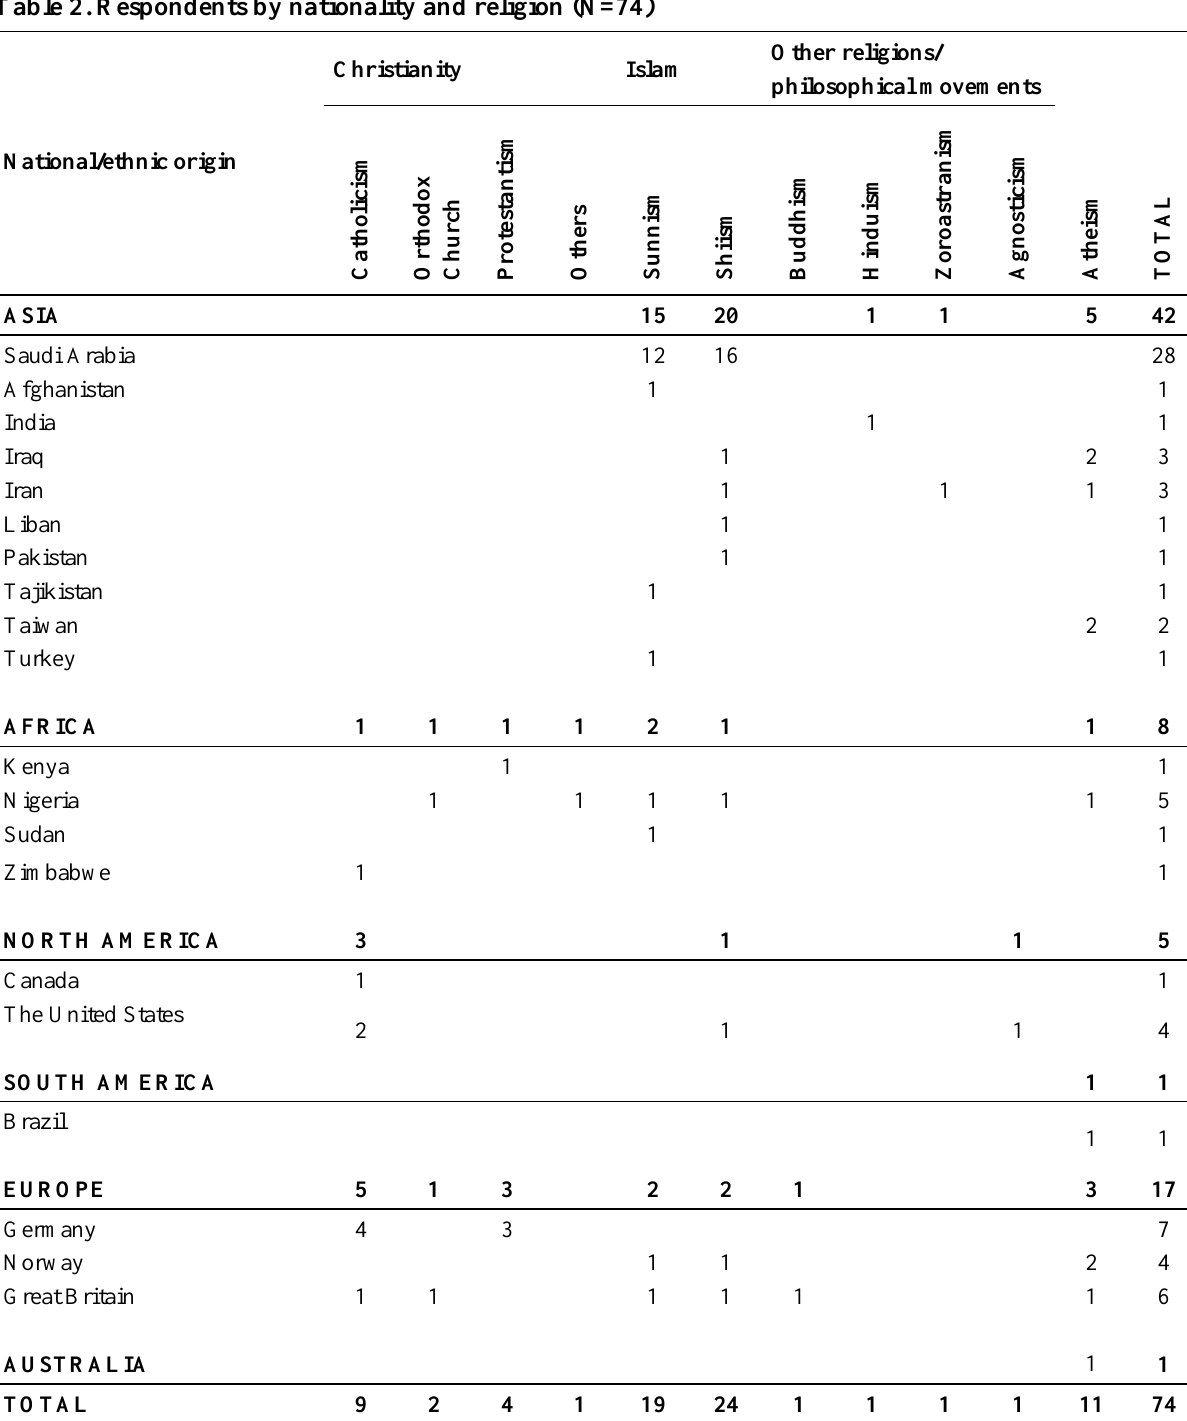
Table 2. Respondents by nationality and religion